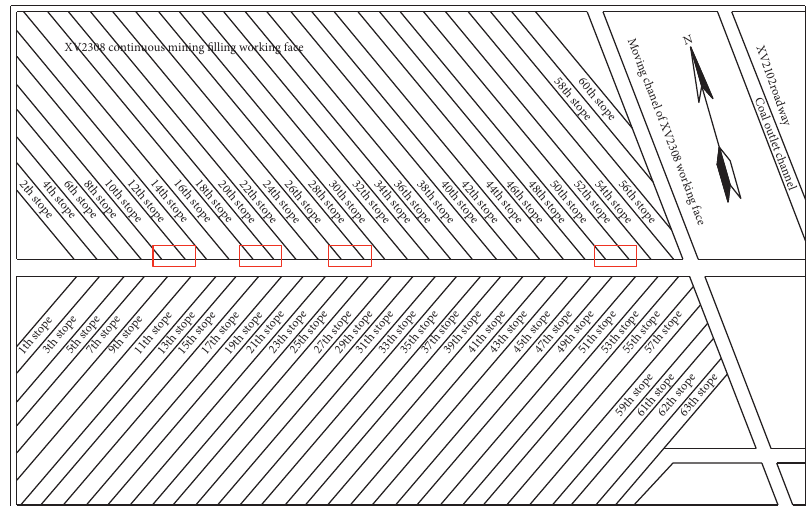
Figure 6: The test sites.